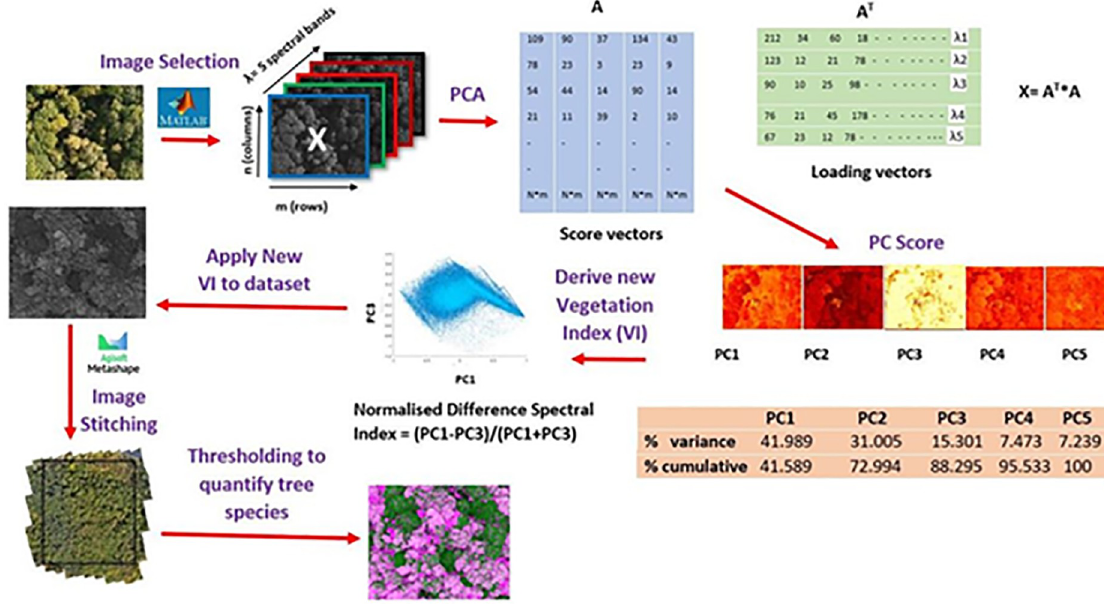
Fig 4. Data processing workflow for Priestclose